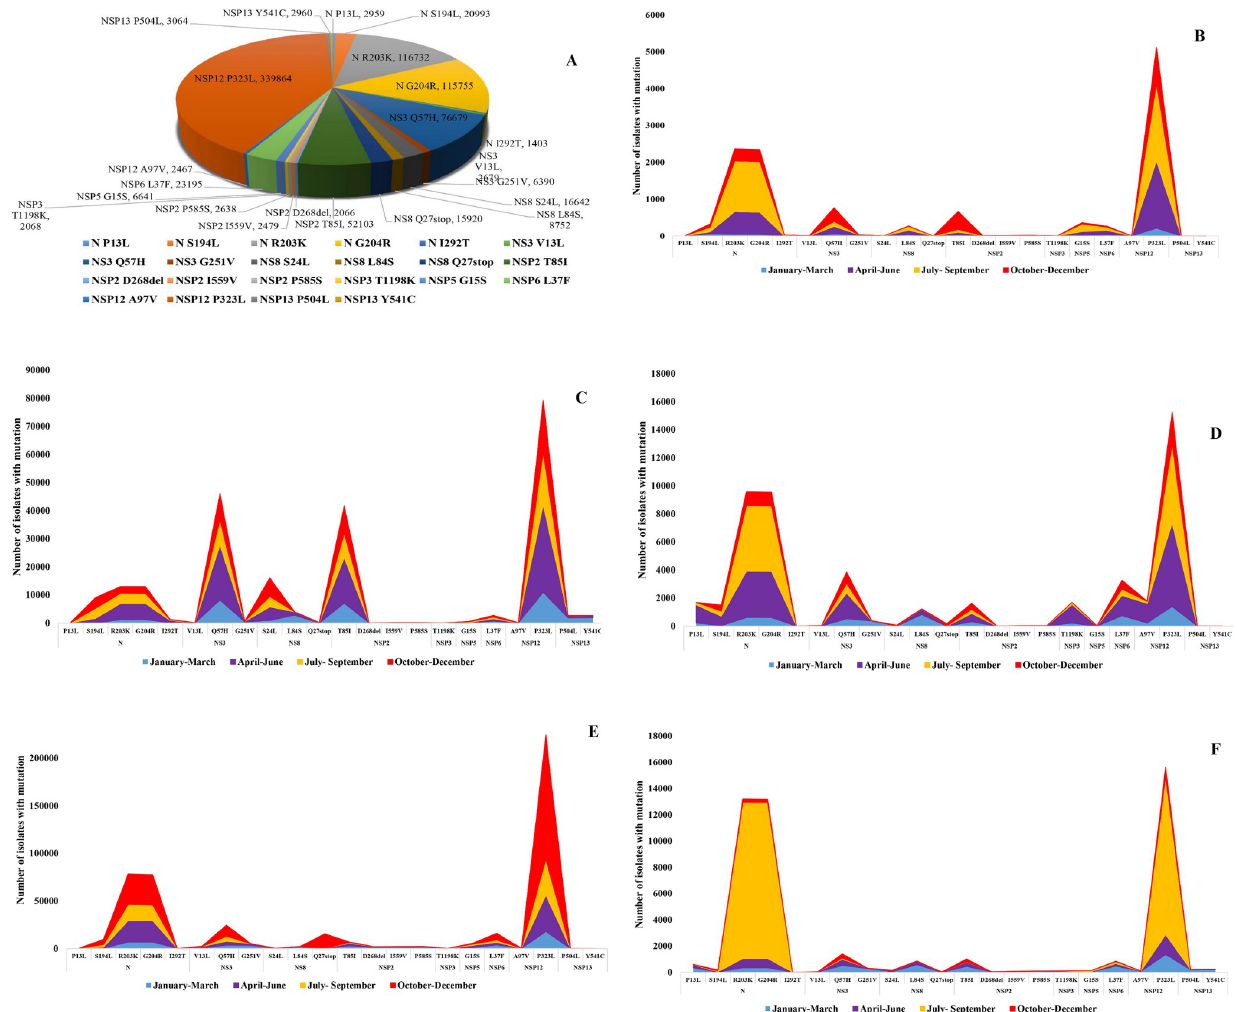
Fig 4. (A) Worldwide distribution of frequency of significant substitution point mutations at nucleocapsid and nonstructural protein of SARS-CoV-2 during January, 2020 to December, 2020. (B) Monthly report of substitution point mutations at nucleocapsid and nonstructural protein of SARS-CoV-2 in Africa and (C) Americas, (D) Asia, (E) Europe, and (F) Oceania during January 01 to December 31, 2020. Wuhan-Hu-1/2019 was used as reference sequence in this